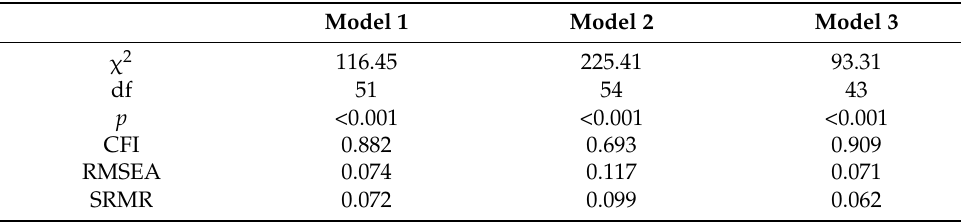
Table 8. Fits for three different structural equation models.